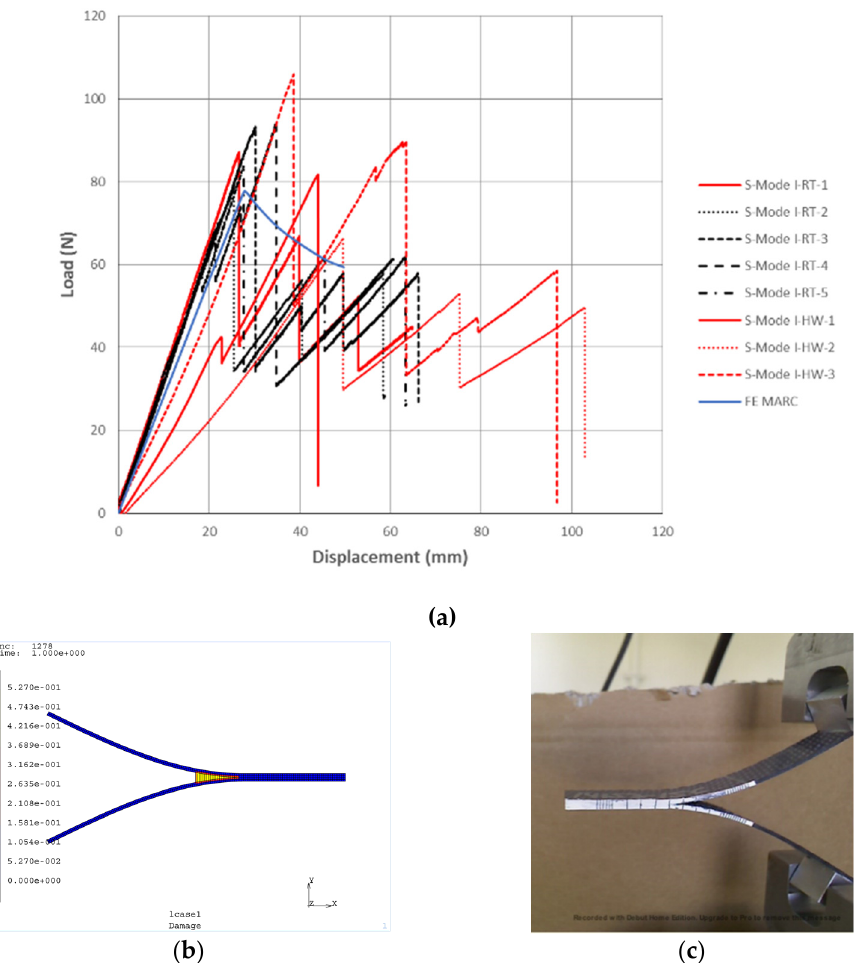
Figure 10. Mode I fracture test: ( a ) measured and predicted load vs. opening displacement data; ( b ) instance of crack propagation prediction; ( c ) typical deformed shape during test.